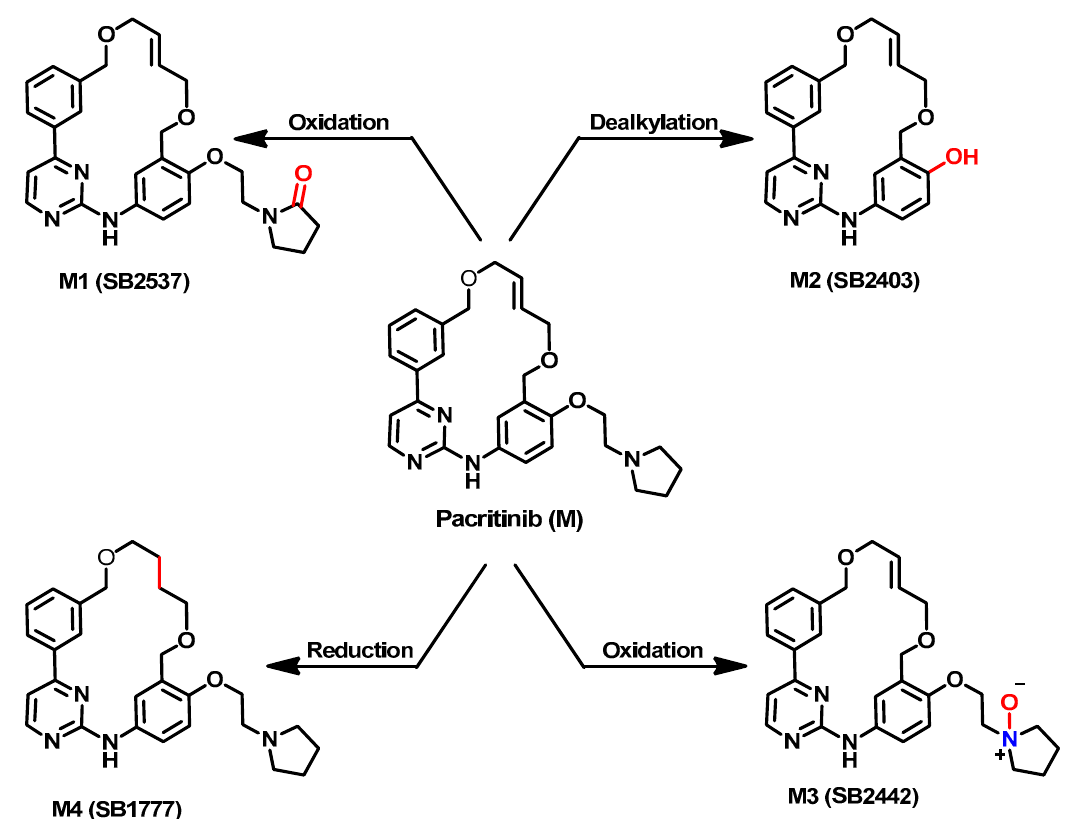
Figure 42. Proposed metabolic pathways and metabolites of pacritinib in human and mouse plasma.